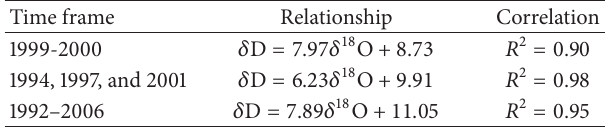
Table 1: Long-term annual multiple correlation of 𝛿 18 O with precipitation, temperature, and relative humidity.